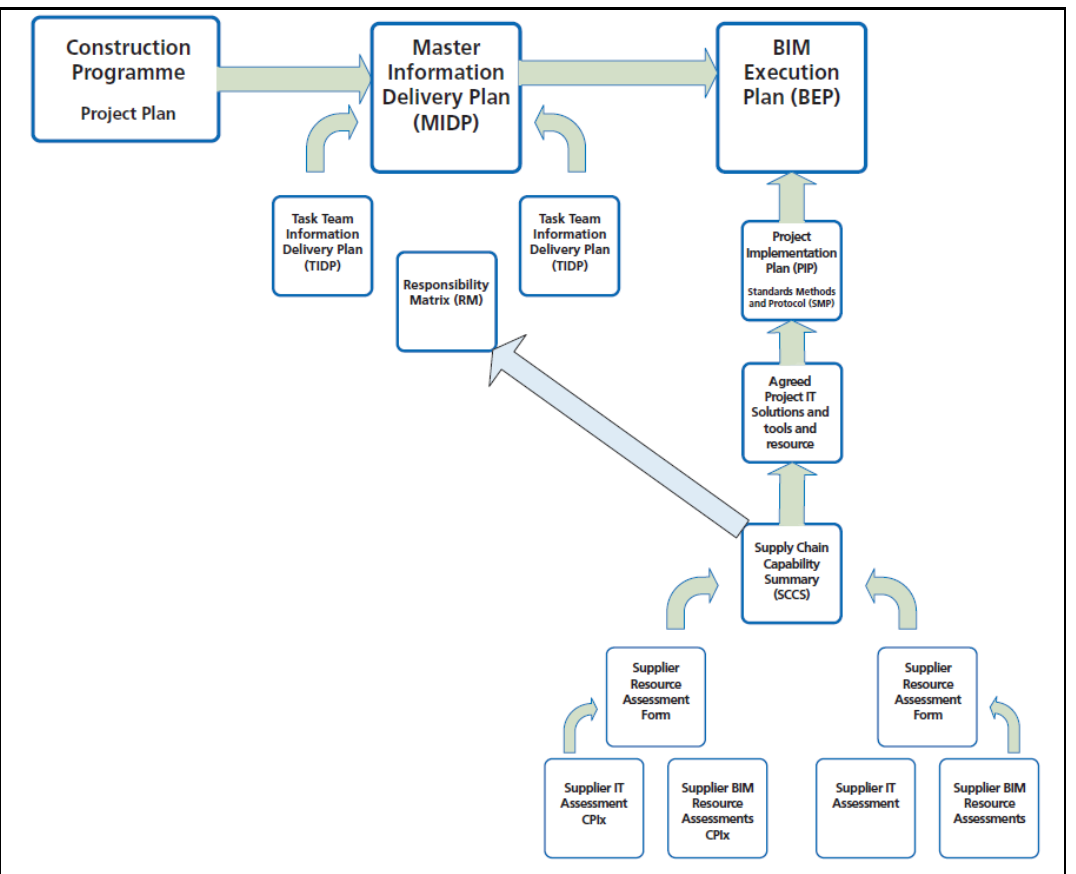
Figure 2: Relationship between documents used for information management